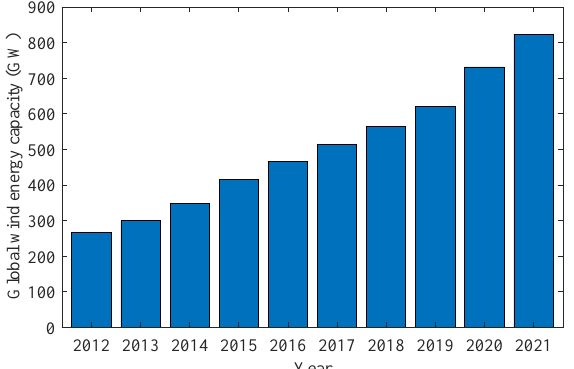
Figure 1. Global wind energy installed